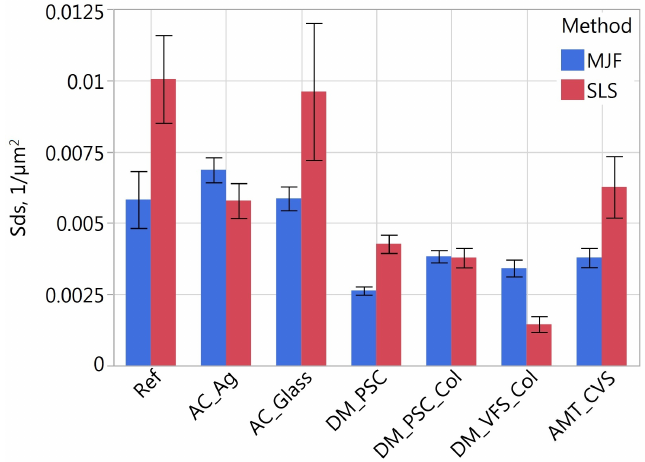
Figure 14. Density of summits Sds of measured